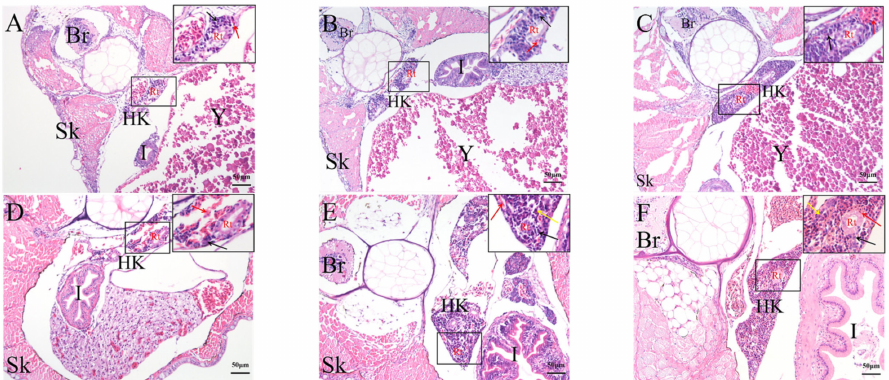
Figure 8. Hematoxylin and eosin staining of histological sections of the rice-field eel kidney from 2 dph to 45 dph. ( A ): 2 dph; ( B ): 6 dph; ( C ): 10 dph; ( D ): 17 dph; ( E ): 24 dph; ( F ): 45 dph. Bars: 50 µ m. Hk: head kidney. Rt: renal tubule. Br: brain. Y: yolk. I: intestine. Sk: skin. Black arrow: lymphocytes. Red arrow: blood cells. Yellow arrow: granulocyte. Sections were stained with HE. The liver has generated at 2 dph, with significant numbers of hepatic sinusoids (Figure 9A). With the continuous development of the fish body, the liver volume